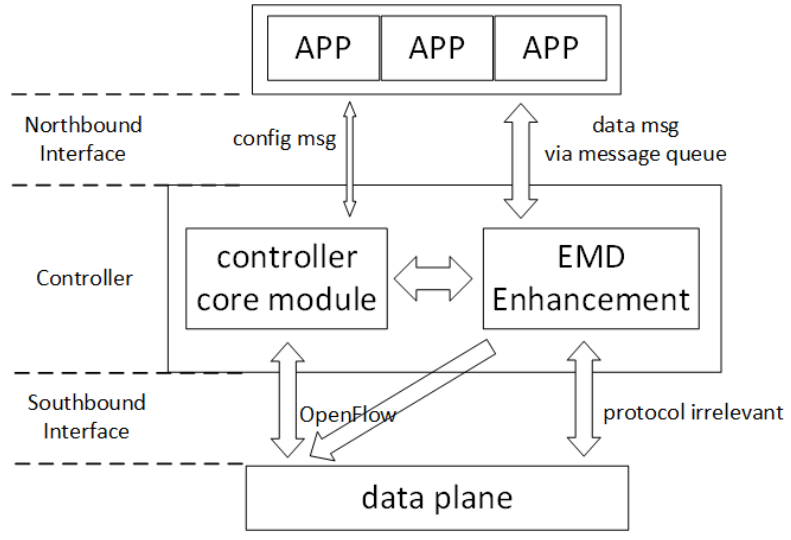
Figure 3. The Overall Structure of SDN with EMD Module.